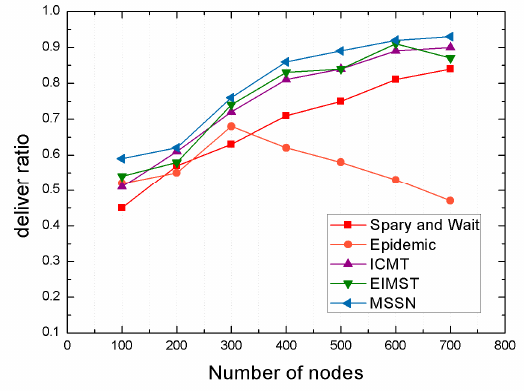
Figure 8. Deliver ratio with different number of nodes.